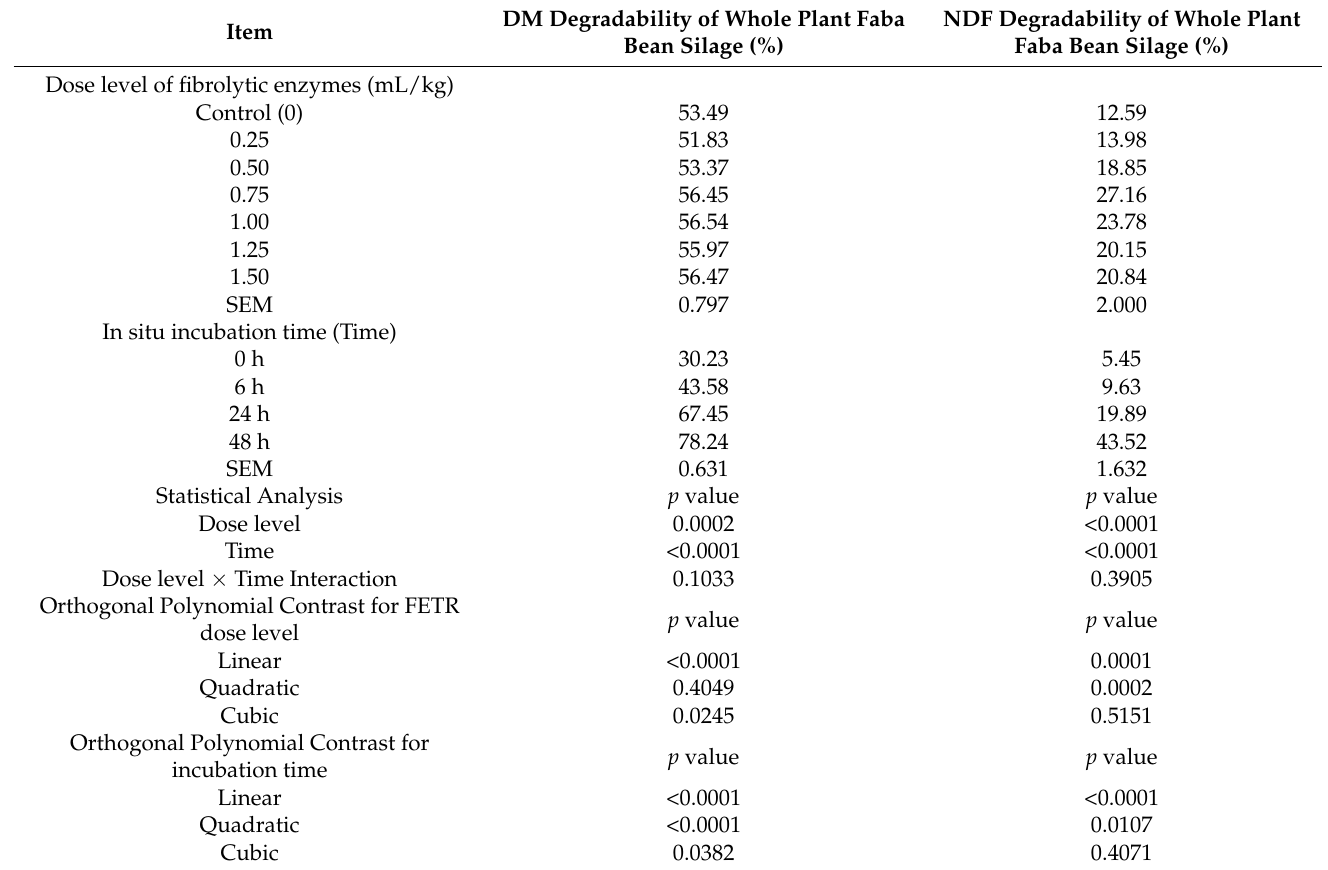
Table 2. Effect of different dosage of fibrolytic enzymes 1 derived from Trichoderma reesei on in situ